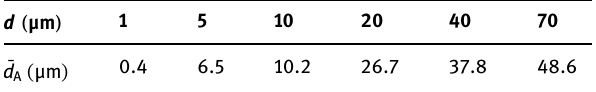
Table 1: A comparison of the original particle diameter